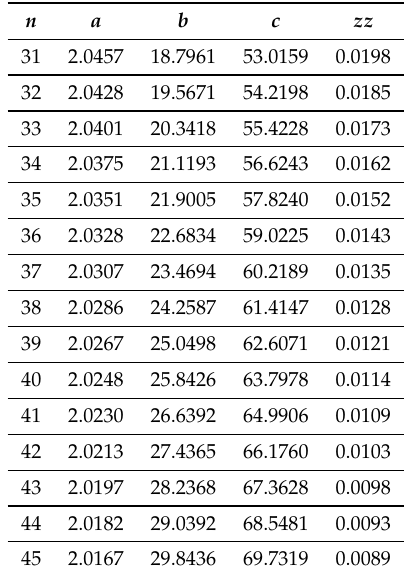
Table 4. Minimizing area point method (confidence level is